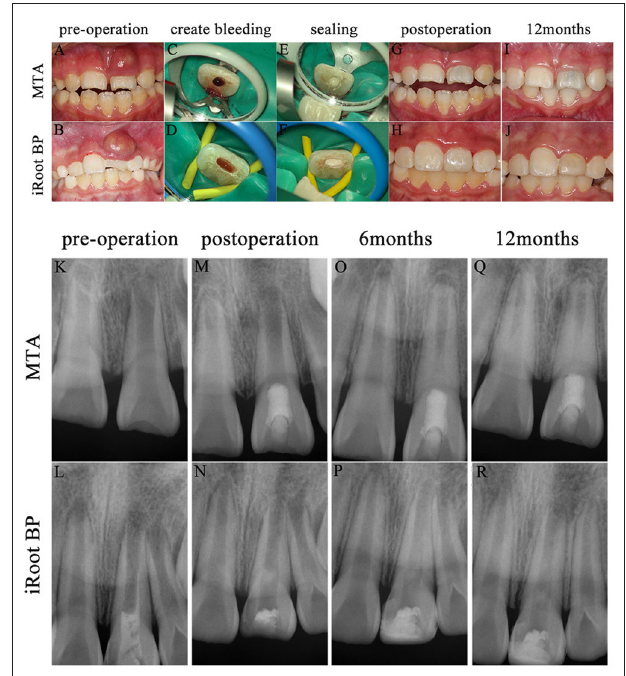
FIGURE 3 | Two cases of pulp revascularization. (1) Preoperative intraoral photographs (A,B) and radiographs (K,L) for each specimen; create bleeding (C,D) ; seal with MTA (E) and iRoot BP (F) ; postoperative intraoral photographs (G,H) and radiographs (M,N) ; radiographs at postoperative 6 months (O,P) ; intraoral photographs (I,J) and radiographs (Q,R) at postoperative 12 months. (2) The pain to percussion disappeared and the fistula healed in both cases after proper irrigation and medication. But, the case sealed with MTA appeared discoloration (G,I) after revascularization operation. (3)